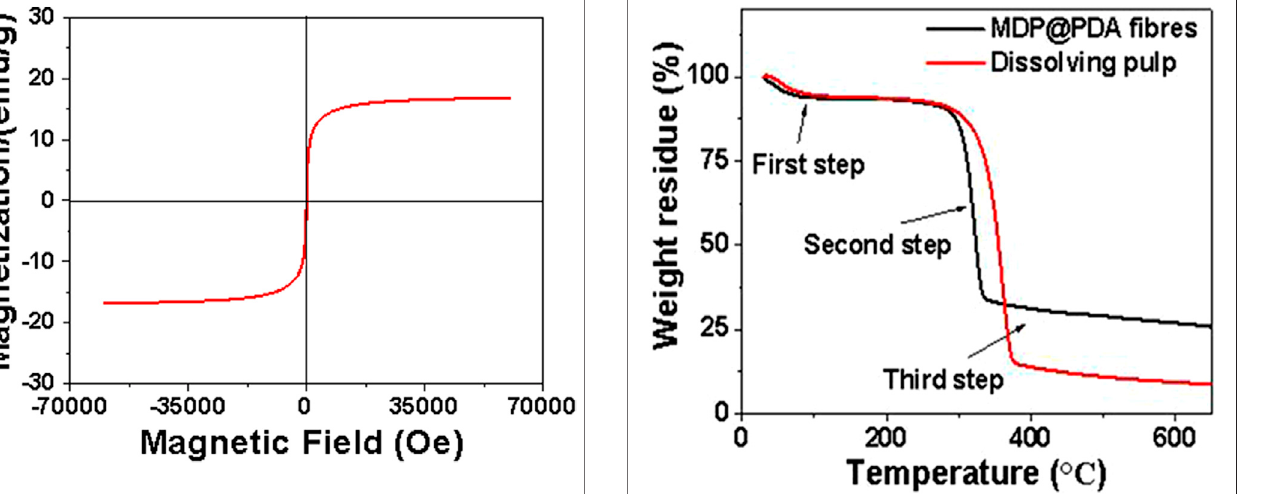
FIGURE 6 | Magnetization curve of the MDP@PDA fi bers.